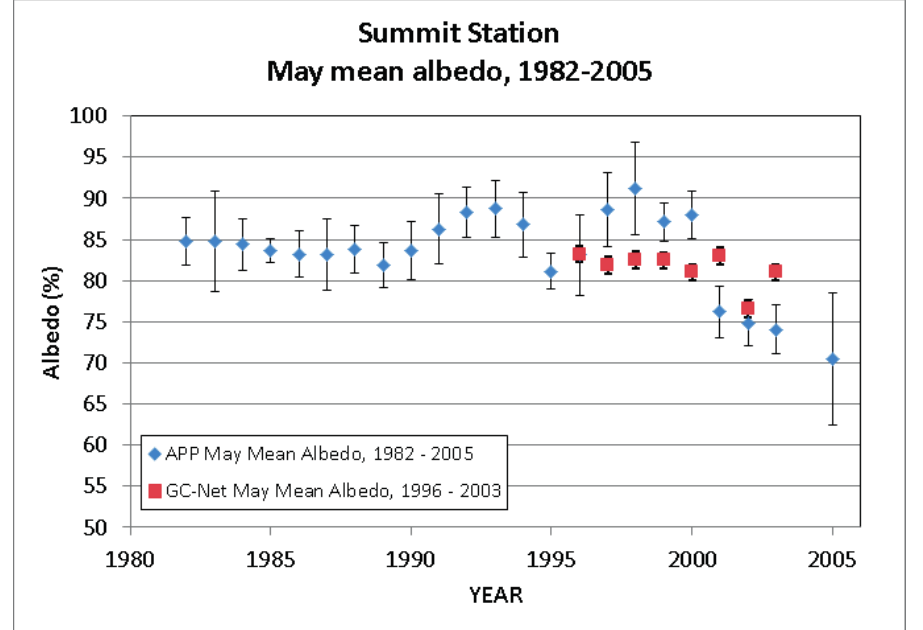
Figure 6. Mean cloud-free May albedo values from the AVHRR Polar Pathfinder (APP) satellite dataset and Greenland Climate Network (GC-Net), for Summit Station, Greenland. The error bars show one standard deviation. The APP albedos are based on pixels with a 25 km 2 ground field of view; the GC-Net albedos were collected in situ . Missing years are due to insufficient data. Of special note is the sudden drop in APP mean albedos starting in